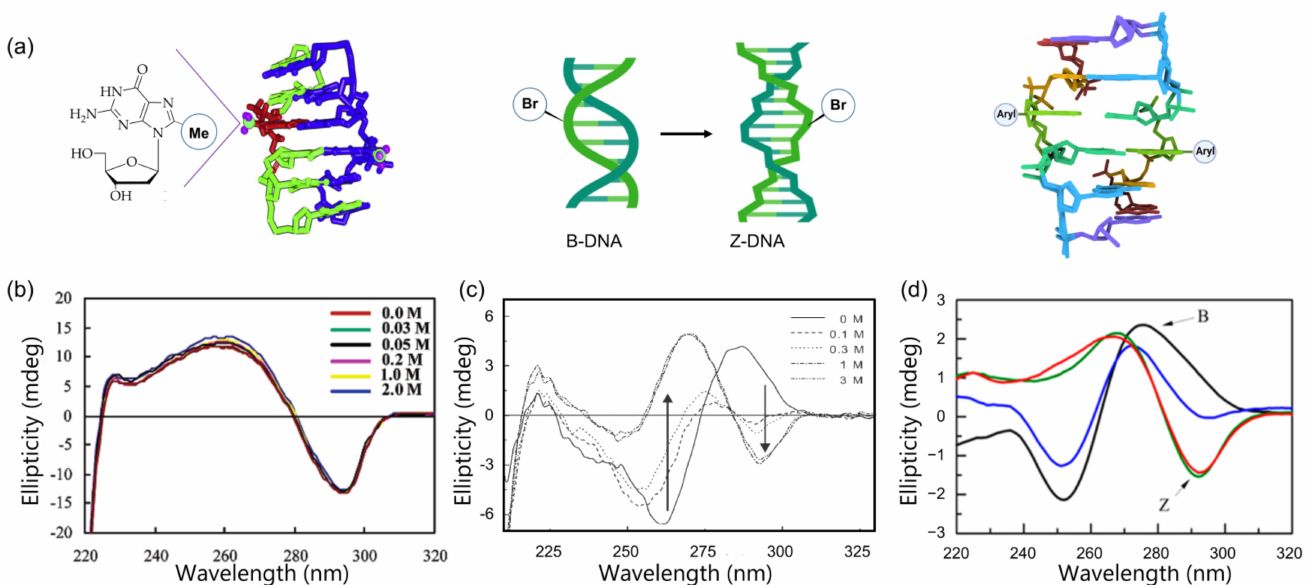
Figure 6. Graphical representations and CD spectra of the preferential structure of modified DNA. ( a ) DNA structure including purines modified with methylation (left), bromination (middle), and arylation (right); ( b ) CD spectra of 8-methyl ribo-guanosine incorporating oligomer stabilized the Z-DNA at low salt concentrations; ( c ) B-Z transition monitored by CD spectra. 8-Bromo-2 (cid:48) -deoxyguanosine containing an octamer sequence (d(CGT Br GCACG) 2 ) dramatically stabilized the Z-form in low-salt physiological conditions; ( d ) CD spectra of the natural sequence and modified hairpin sequence in salt physiological condition from Ref. [89]. Arrows indicate the signature band of Z-DNA. Copyright (2003), (2004), and (2014), American Chemical